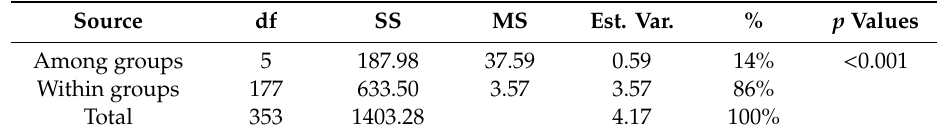
Table 3. The partitioning of genetic variation within and among groups obtained with AMOVA analysis on the six olive groups having different geographical origin.